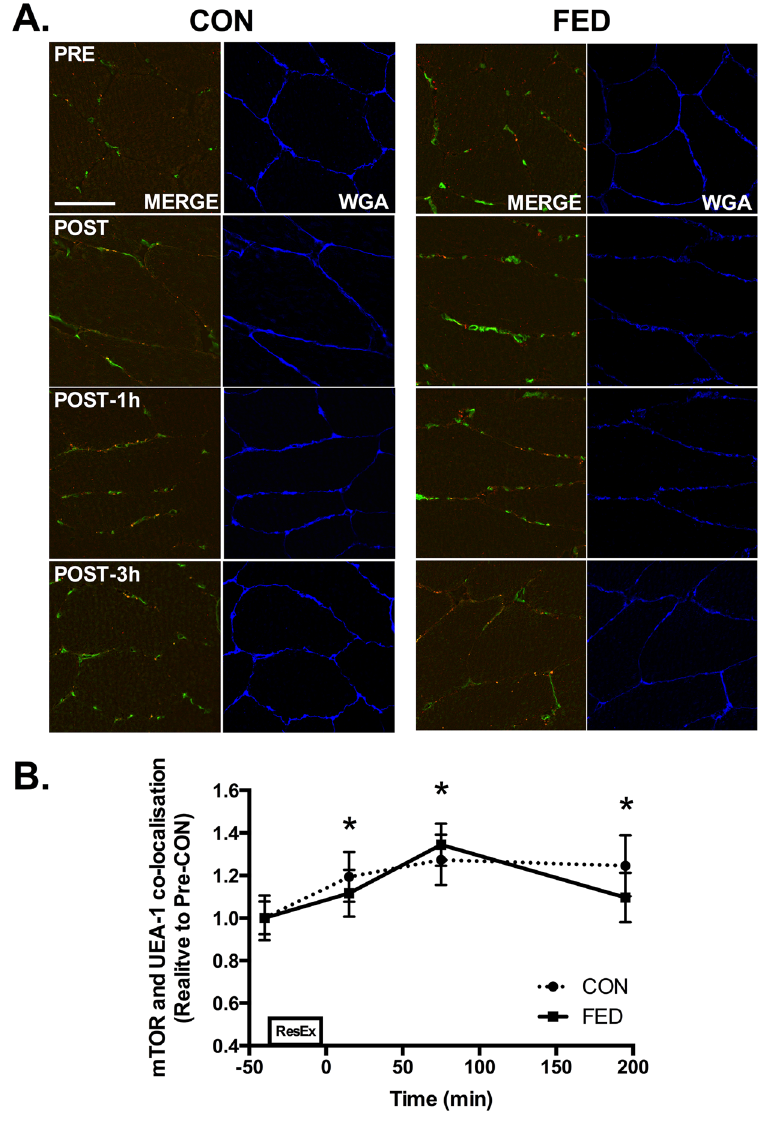
Figure 5. mTOR translocates to the microvasculature following resistance exercise. Immunofluorescence quantification of mTOR (Red) and UEA-I (Green) interaction, displayed as a composite image (Merge) and WGA (Blue). Yellow regions represent mTOR and UEA-I interaction. Each panel represents one subject from CON and FED across the experimental time course ( A ). Group data is quantified and reported in ( B ). Circles represent CON, squares represent FED. All image processing was kept constant between images, including exposure time, gain, and image frame. All data presented relative to the Pre exercise CON. Data presented as mean ± SEM (n = 7/group). * Significantly different to PRE-CON ( P <